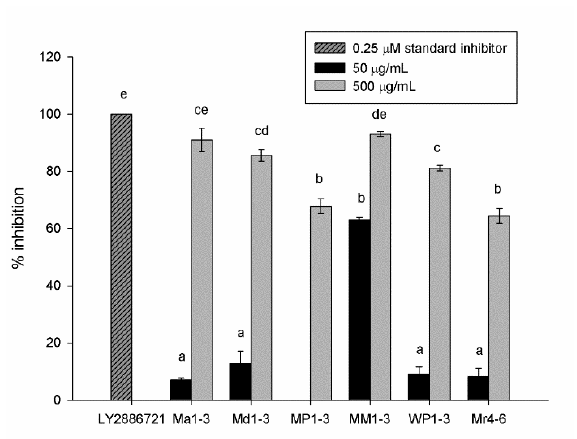
Figure 1. Percentage inhibition of β-secretase (BACE) of Mentha australis (Ma1-3), M. diemenica (Md1-3), M. spicata var. crispa (MM1-3), M. × piperita (MP1-3), M. × piperita var. officinalis (WP1-3) and M. requienii (Mr4-6). Results are presented as mean ± standard error (SE) ( n = 3). Different letters indicate a significant difference at p < 0.05. 50 µg/mL MP1-3 resulted in no inhibition.